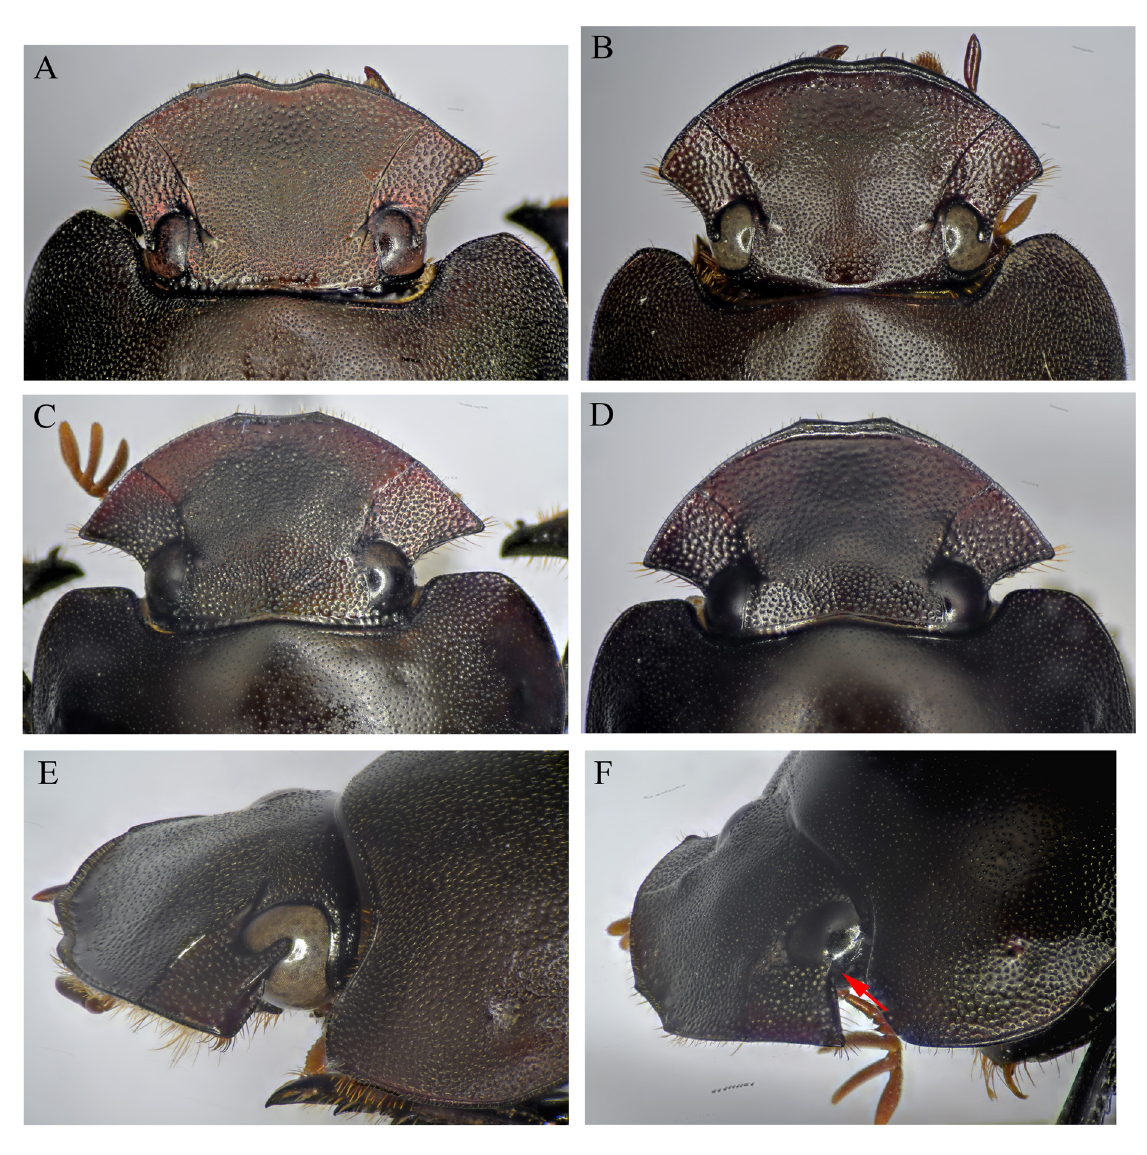
Fig. 5. Head. A‒D . Dorsal view. A‒B . Streblopus opatroides van Lansberge, 1874. A . ♂. B . ♀. C‒D . S. punctatus (Balthasar, 1938). C . ♂. D . ♀. Note how the emargination of the apex of the